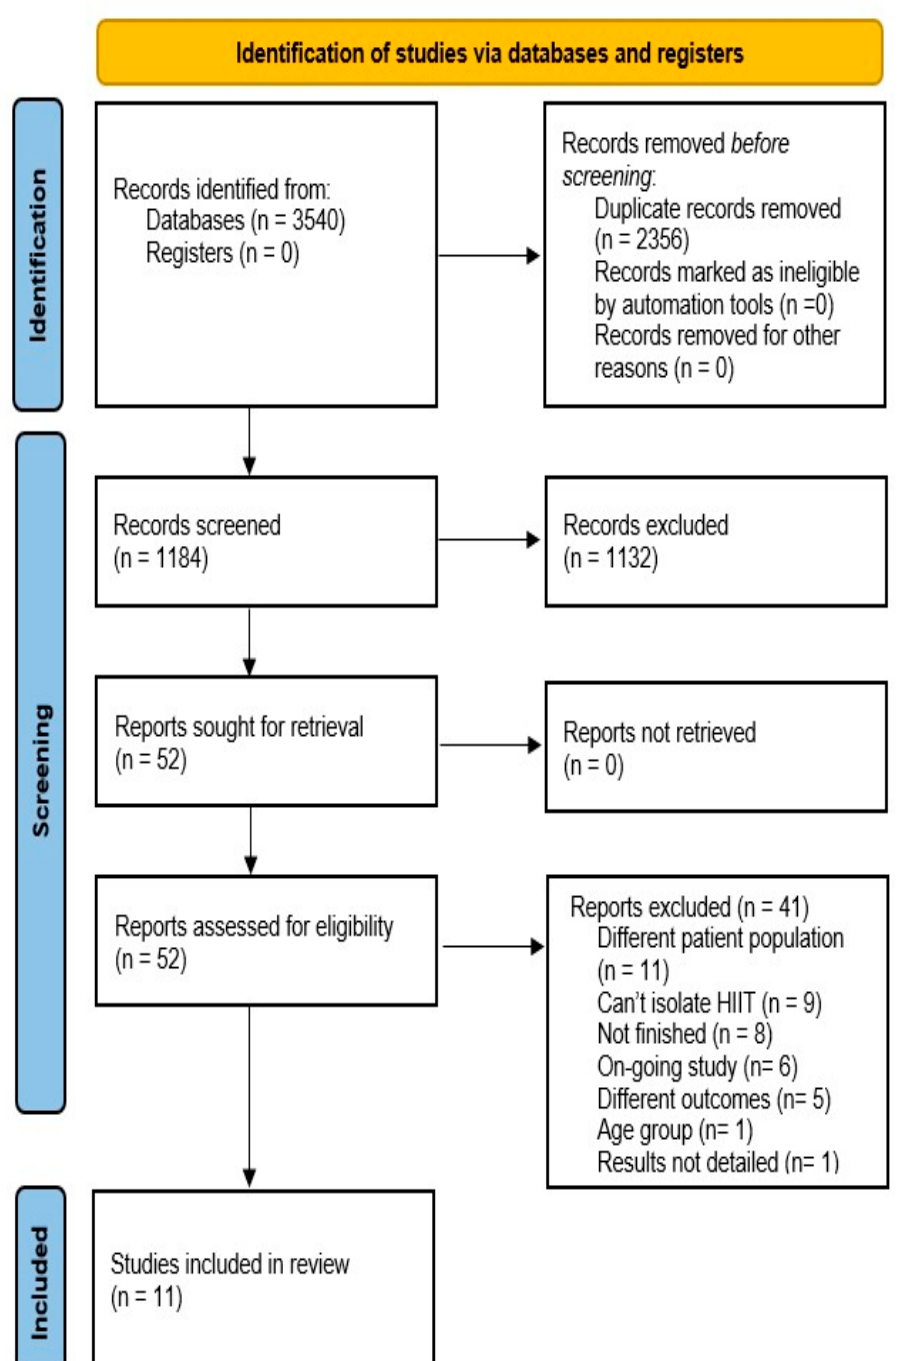
Figure 1. PRISMA flow diagram to depict search strategy results.